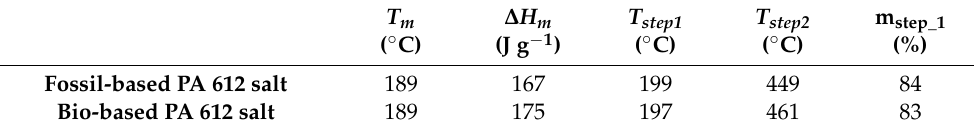
Table 3. Thermal properties of PA 612 salts (DSC single heating, TGA).